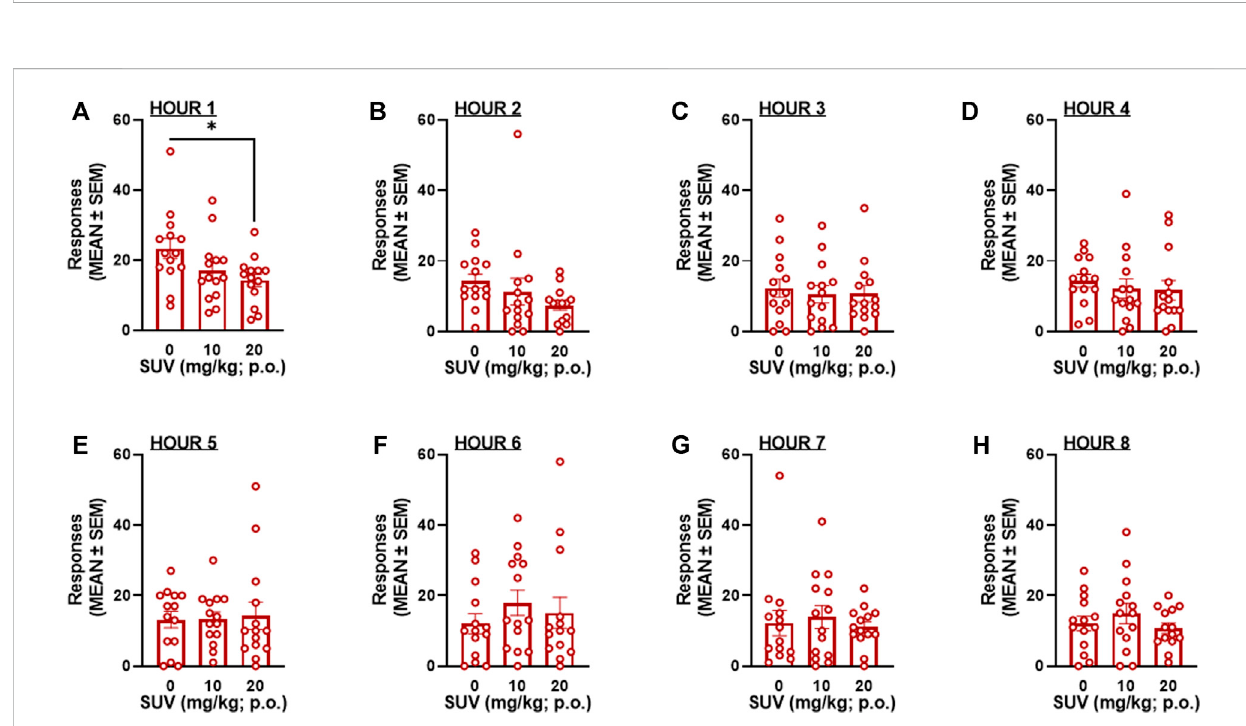
FIGURE 5 Oxycodone self-administration following suvorexant administration in females ( n = 14) during the fi rst hour of the session (A) and during each subsequent hour (B) : hour 2, (C) hour 3, (D) hour 4, (E) hour 5, (F) hour 6, (G) hour 7, (H) hour 8 of the 8-h session. * p < 0.05, vs. 0 mg/kg (Bonferroni multiple-comparison post hoc